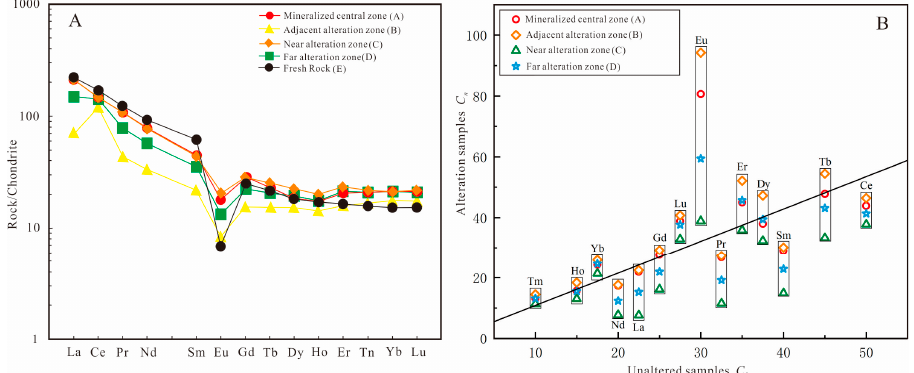
Figure 8. ( A ) chondrite normalized REE pattern diagram (normalization values after ref. [24]) and ( B ) standardized Isocon diagram for REE.